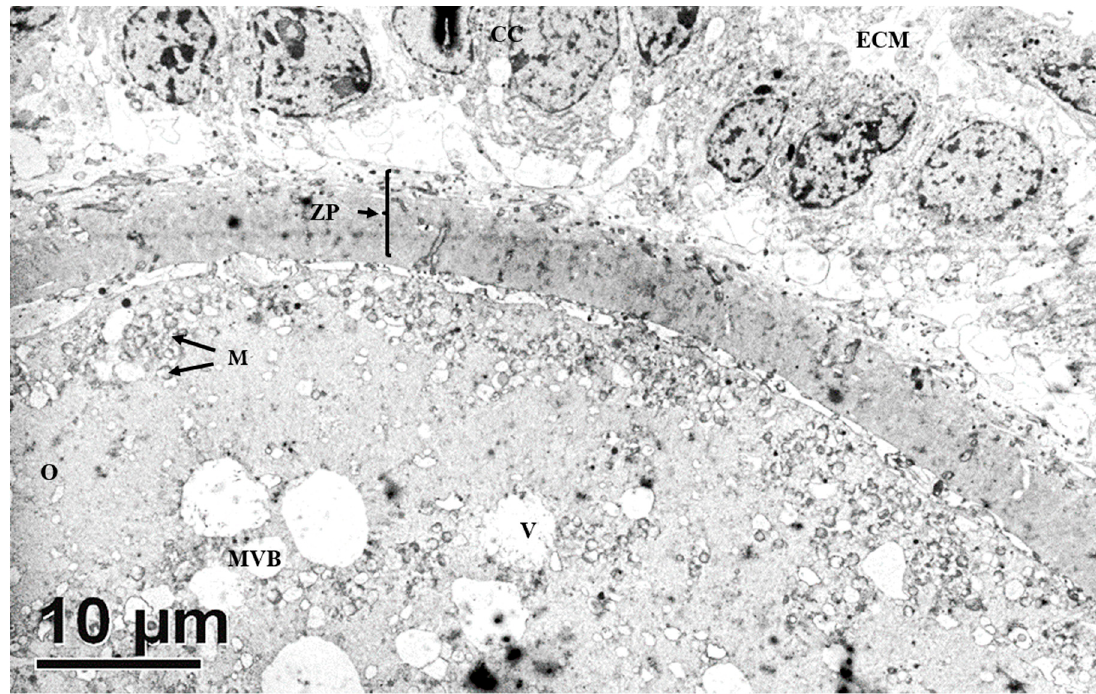
Figure 5. Transmission electron microscopic view of immature oocytes from antral follicles. The oocyte has fully formed zona pellucida (ZP), compact cumulus cells with minimal extracellular matrix (ECM), organelle aggregates, and clusters of mitochondria (M) beneath the vitelline membrane and in the ooplasm. CC, cumulus cell; M, mitochondrion; O, oocyte. Animals 2020 , 10 , x